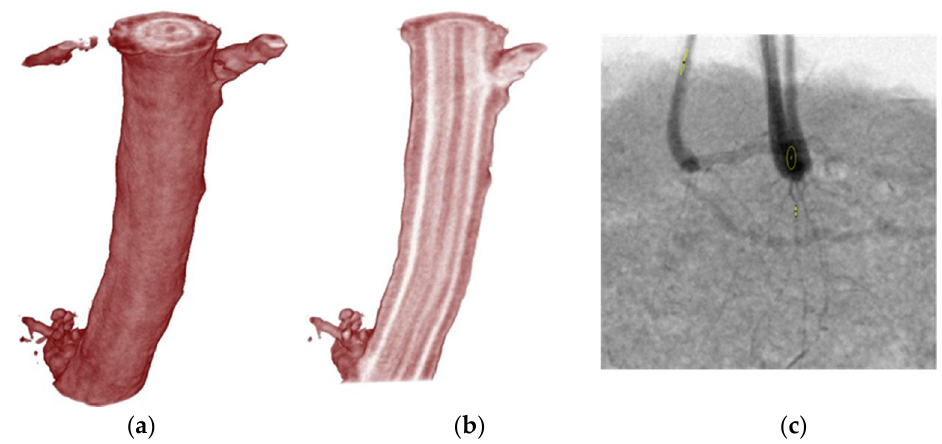
Figure 13. Neutron tomography of an intact pine root ( a ), vertical cross section showing bands of high (light) and low (dark) water content of the same root ( b ) imaged through soil and neutron radiograph of grass roots through soil ( c ).